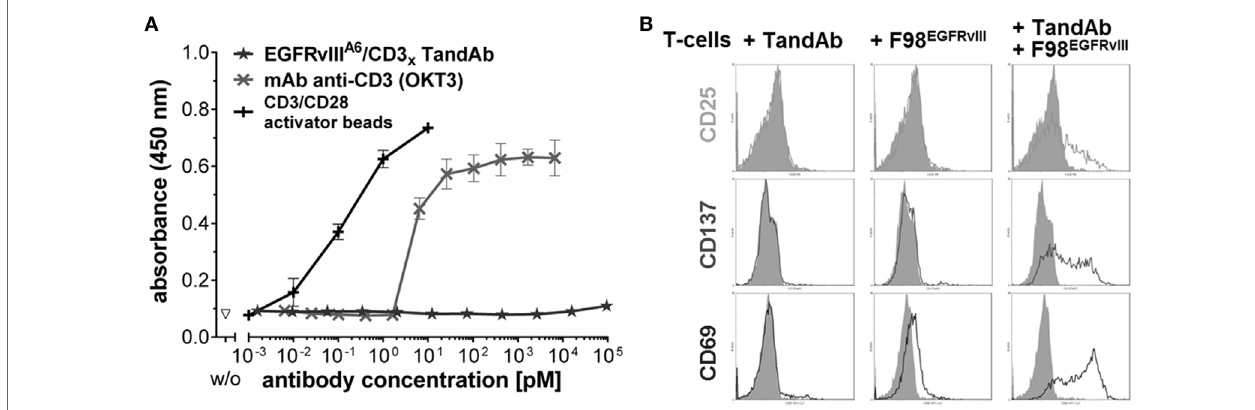
FigUre 5 | egFrviii/cD3 tandem diabody (Tandab) does not facilitate activation of human T-cells in the absence of egFrviii-positive target cells . (a) No PBMC proliferation is induced by EGFRvIII A6 /CD3 x TandAb despite bivalent binding sites for CD3 after cultivation for 5 days and analyzed by BrdU incorporation assay. Control antibody OKT3 induces proliferation. Control cells were cultured in the absence of antibodies (w/o). Mean absorbance, and SD of triplicates, measured at 450 nm are plotted. (B) T-cell activation marker analysis by FACS: primary human T-cells were cultured for 24 h with or without 10 µg/mL of EGFRvIII Li3G30 /CD3 x TandAb in the presence or absence of F98 EGFRvIII target cells at an E:T ratio of 1:1 before T-cells were analyzed for expression of the activation markers by flow cytometry. As a control, cells were cultured in the absence of antibodies and in the absence of target cells (gray histograms). Activation markers are induced on T-cells only when both, target-positive cells and the TandAb are